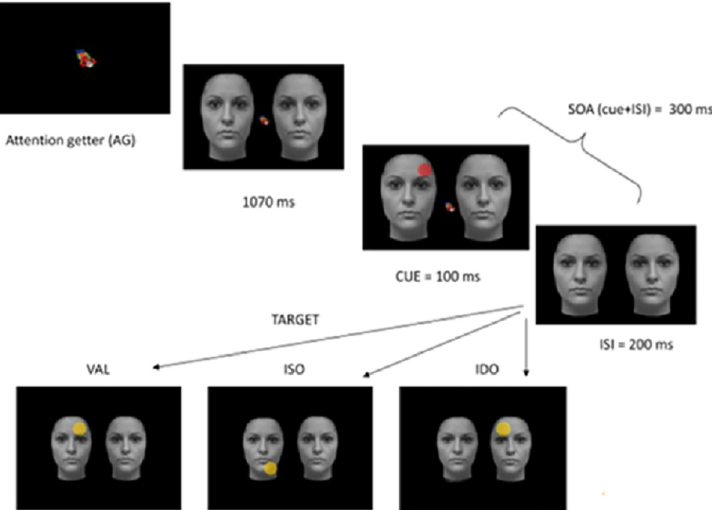
Fig 2. An example of the three possible target locations (yellow dot): In the Valid (V), Invalid Same-Object (ISO) and Invalid Different-Object (IDO) with respect to the cue’s position (red dot).